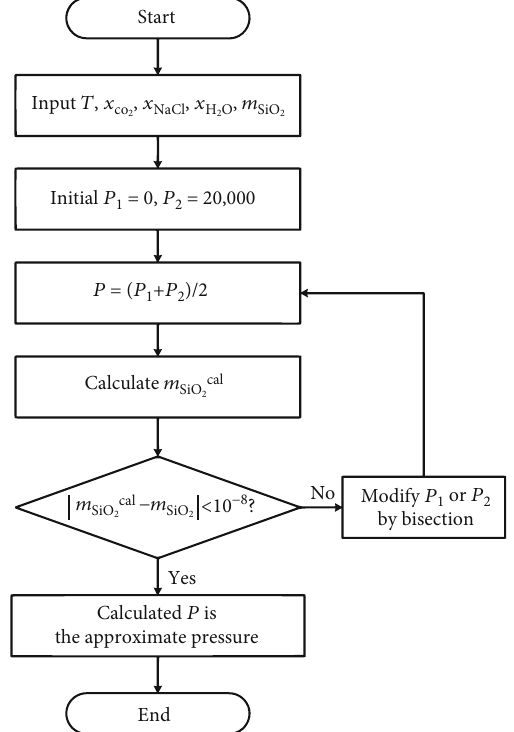
Figure 4: A fl ow chart on bisection algorithm for calculating quartz solubility isopleths in H Parameters of T , x de fi ned in the text,